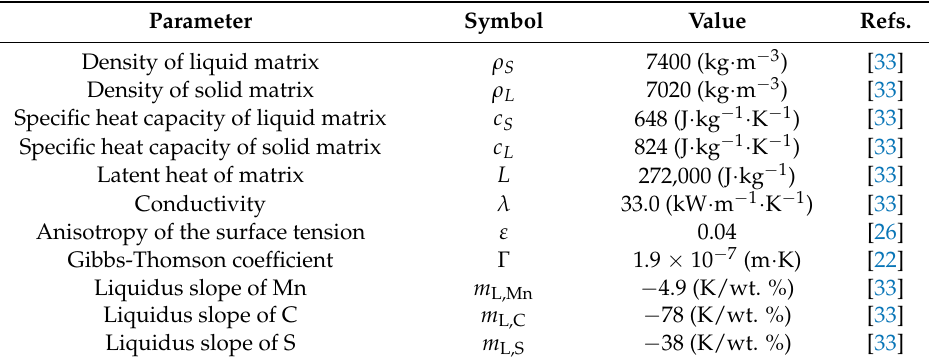
Table A1. Data for heat transfer and the LGK model.